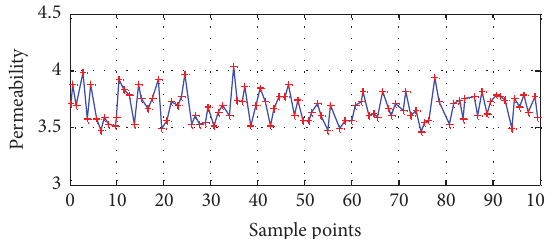
Figure 9: Comprehensive gas permeability operation